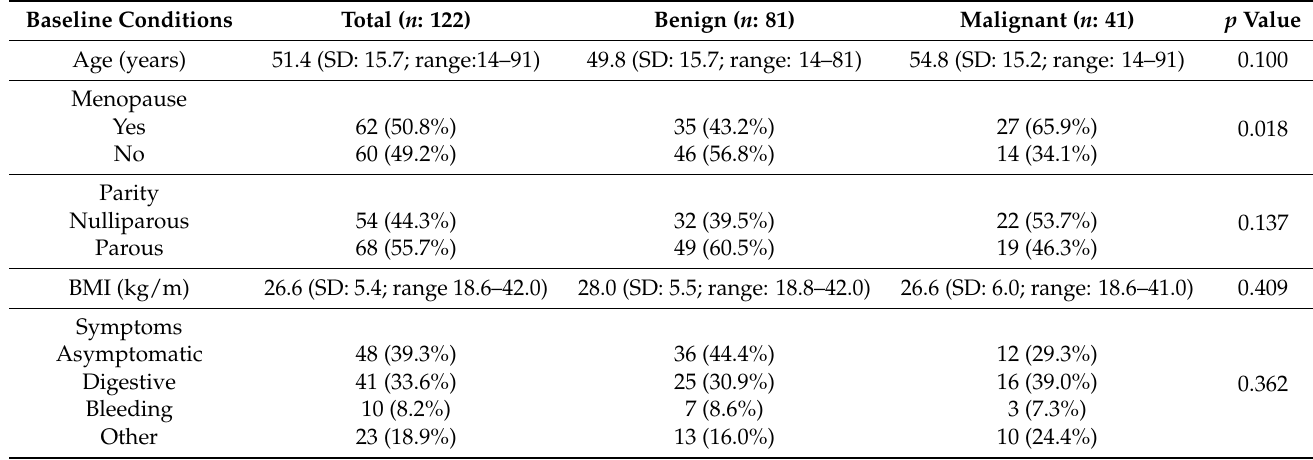
Table 5. Baseline characteristics of the patients in the present study.